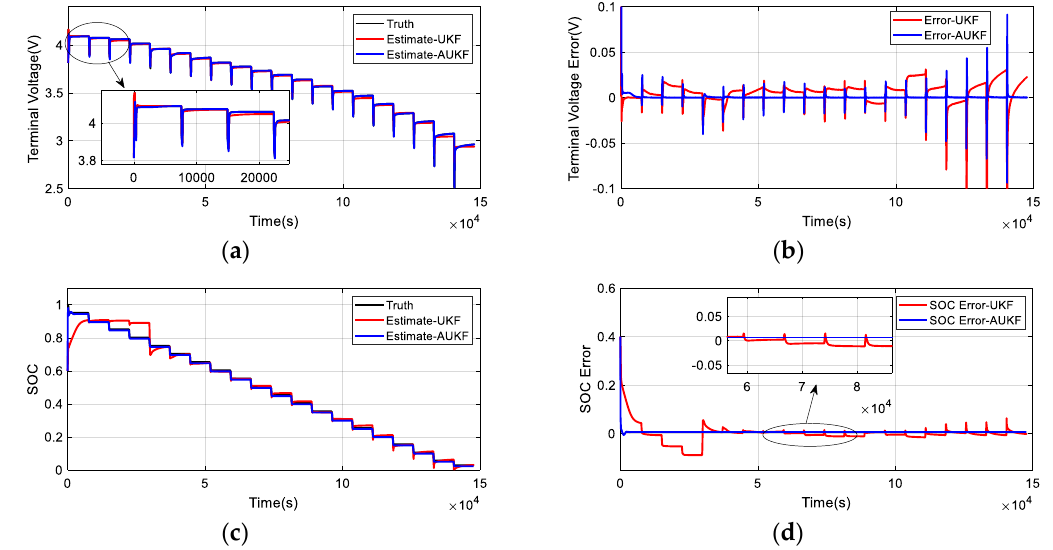
Figure 15. For the initial SOC = 0.6, the comparison of the estimation results of the UKF algorithm and the AUKF algorithm under pulsed discharge conditions. ( a ) Comparison of terminal voltage. ( b ) Comparison of terminal voltage errors. ( c ) Comparison of SOC. ( d ) Comparison of SOC errors.